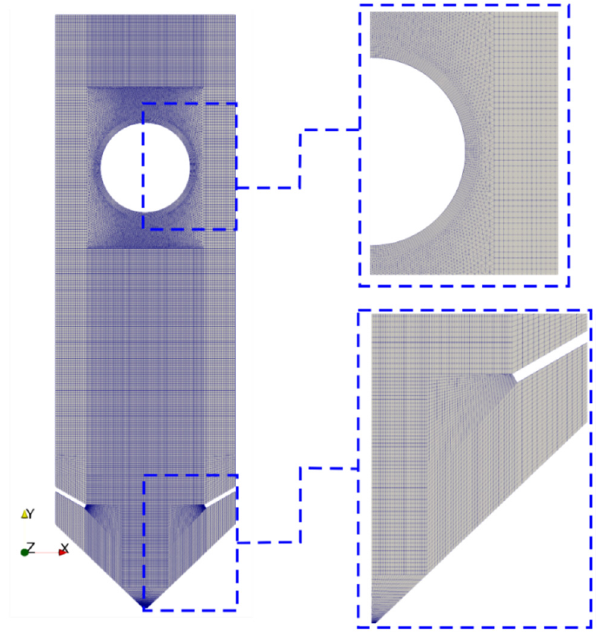
Figure 2. Hybrid 2D computational mesh properties: 48,858 computational cells (34,906 hexahedral and 13,952 prisms cells); maximum aspect ratio of 6.57; maximum non-orthogonality of 48.42°, and a non-orthogonality average of 12.74°; maximum skewness of 1.44.